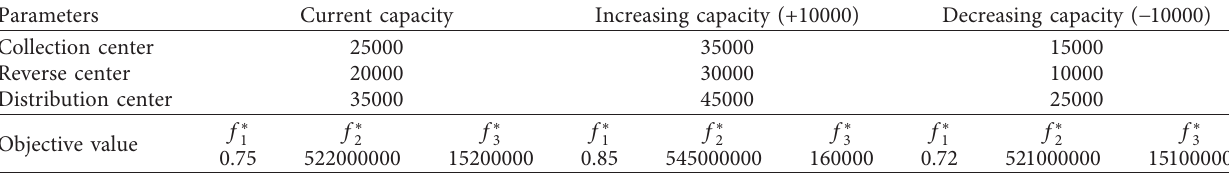
Table 7: Sensitivity